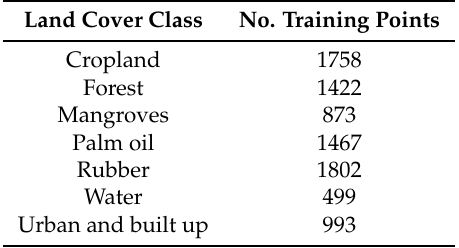
Table 2. Tally of the number of reference data points collected for each